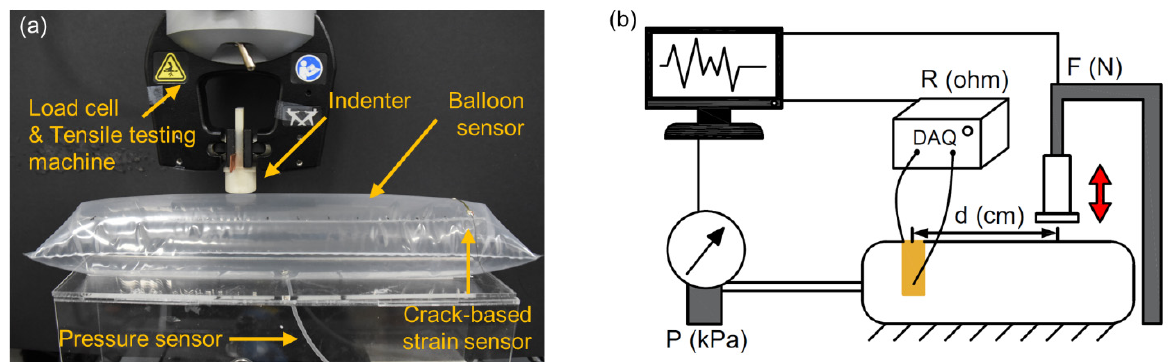
Figure 4. Photograph ( a ) and schematic illustration ( b ) of the experimental setup for sensor characterization.